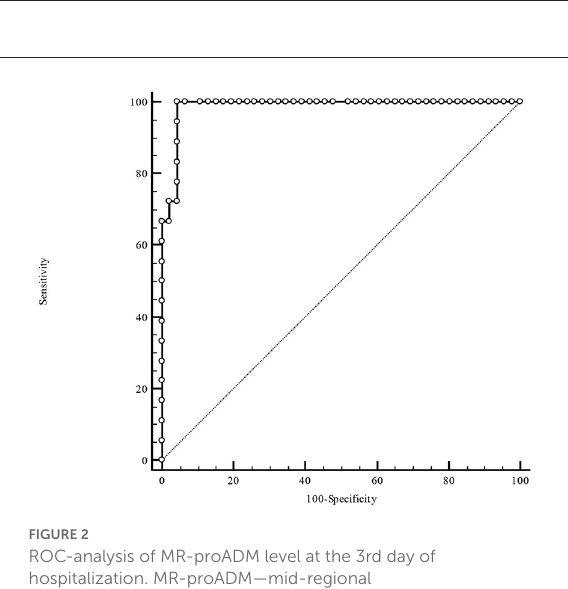
FIGURE2 ROC-analysis of MR-proADM level at the 3rd day of hospitalization. MR-proADM—mid-regional